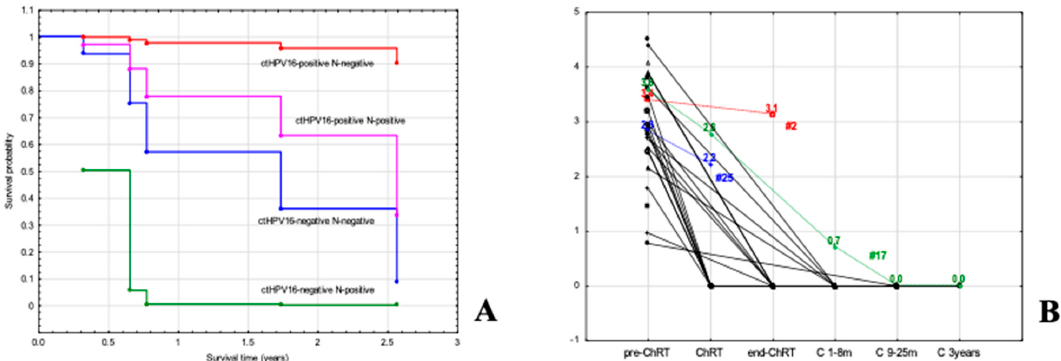
Figure 3. ( A ) Cox proportional hazard model for N and ctHPV16 status in patients with large SU‑ Vmax (>13.6). ( B ) Monitoring of ctHPV16 − positive patients.